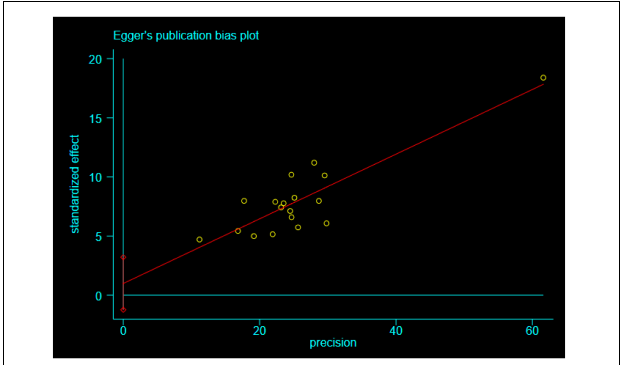
FIGURE 3 | Funnel plot of publication bias for the relationship between IAD and negative life events.